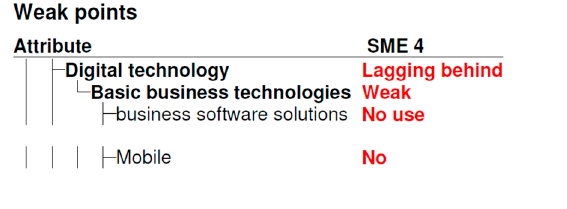
Figure 6. Weak and strong point analysis of the ( a ) SME 4 and ( b ) SME 6.